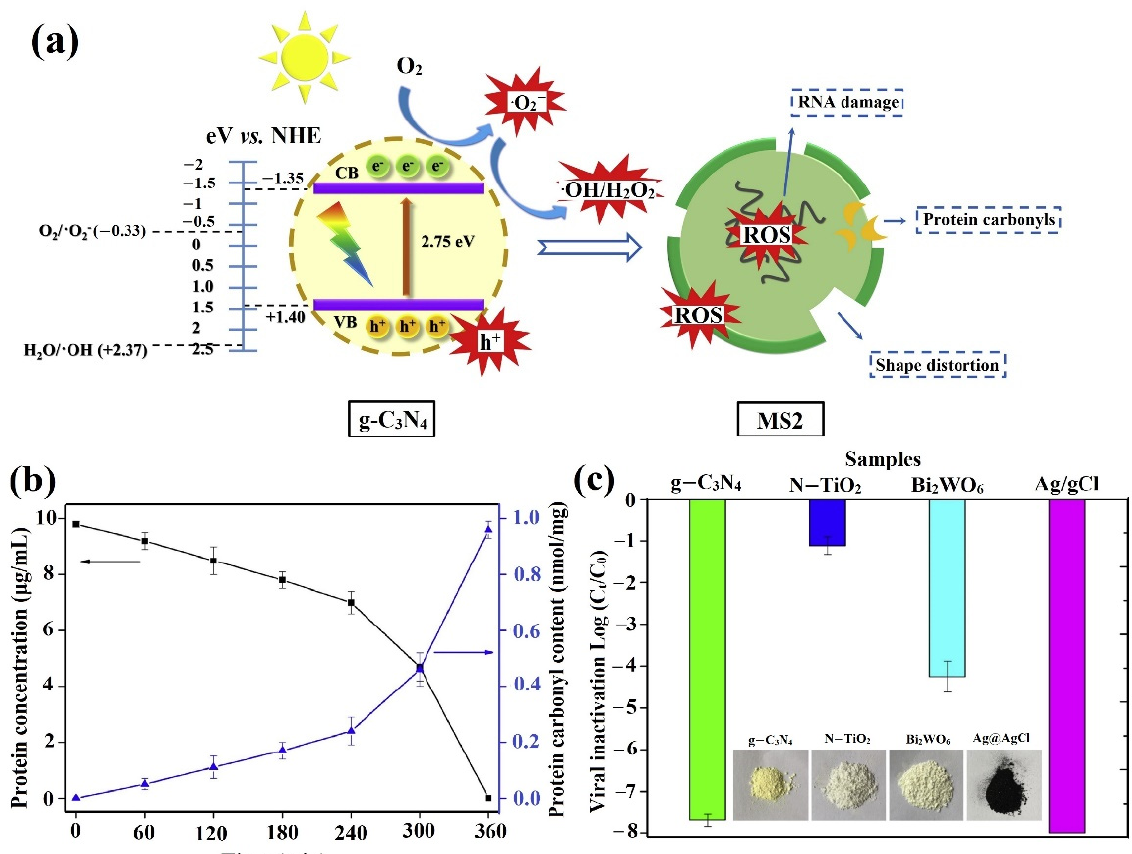
Figure 2. ( a ) Schematic representation of the viral inactivation mechanism of g-C 3 N 4 under visible-light exposure; ( b ) protein concentration measurements in 100 µ L of a solution of viral particle lysates from 5 mL of a virus-related suspension (1 × 10 8 PFU/mL) and the amount of protein carbonyls during the inactivation process; ( c ) photocatalytic activity of Ag@AgCl, Bi 2 WO 6 , N-TiO 2 , and g-C 3 N 4 samples with 150 mg/L dosages for MS2 inactivation upon exposure to visible light. Reproduced with permission from [28] with license number 5136360326508. Copyright Elsevier 2016.